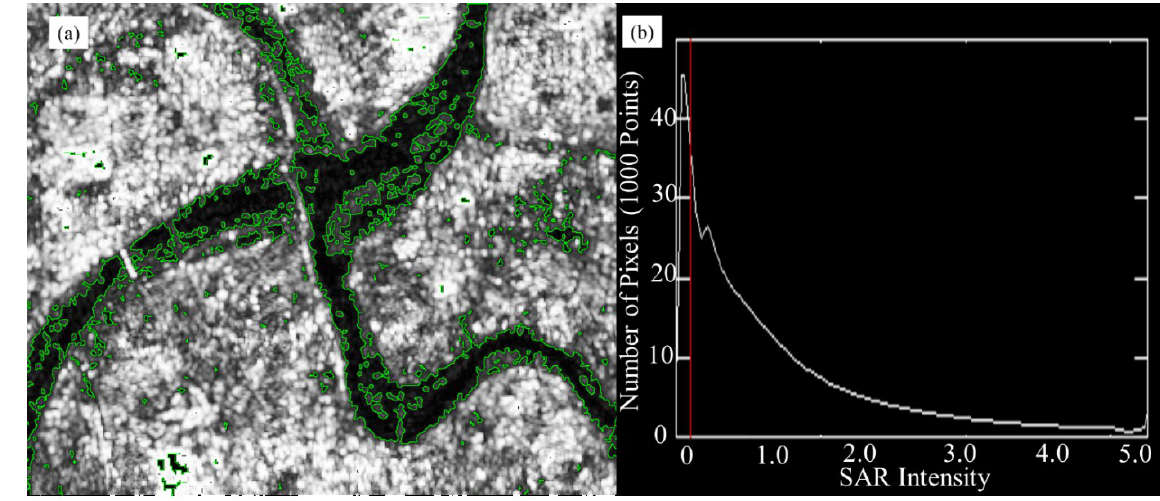
Figure 6. An example of the high ratio of the dark region in one scene. ( a ) Dark regions determined by ESARIWDS (green polygons). ( b ) Histogram of the current scene, which exhibits a bimodal pattern.